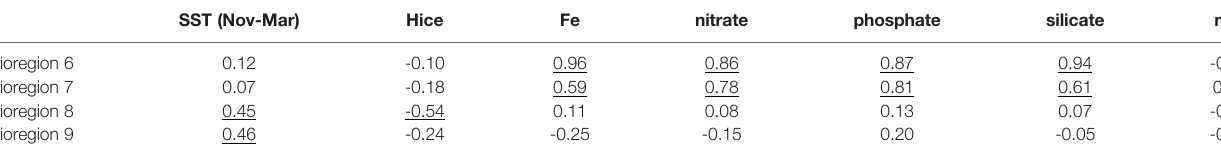
TABLE 3 | Correlation between primary production and environmental factors of bioregion 6, 7, 8 and